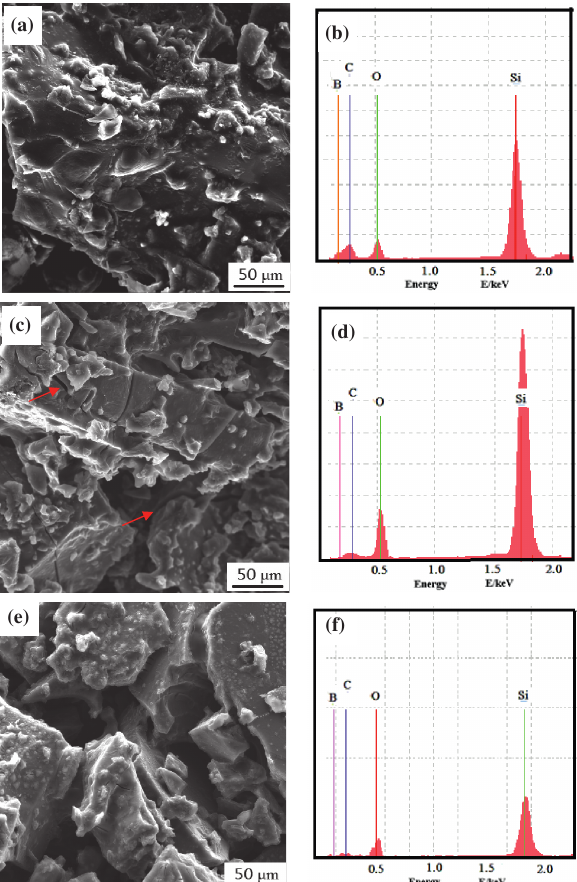
Figure 2: Typical SEM images and EDS spectra of the B-Si carbon materials obtained by carbonization treatment at different temperatures (a, b) 800°C, (c, d) 1,200°C and (e, f)